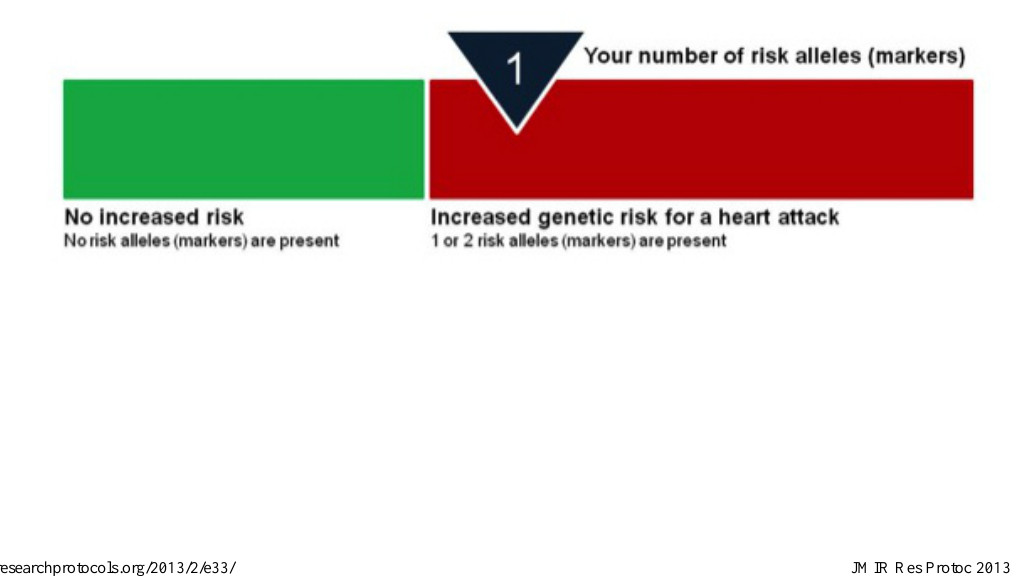
Figure 2. Genetic risk score. Through your blood work, we looked for a specific SNP in your DNA which has been shown to be a marker for heart attack risk. This SNP is located on chromosome 9, and is known as 9p21. The SNP is not within a gene itself, but is likely closely related to a gene which causes coronary artery disease. The 9p21 SNP has been shown to increase heart attack risk in several different ethnic groups, including South Asians. Based on your blood work, we determined if you did not have this SNP, only had it on one chromosome (inherited from one parent), or had it on two chromosomes (inherited from both parents). Having either one or two copies of this marker increases your genetic risk of having a heart